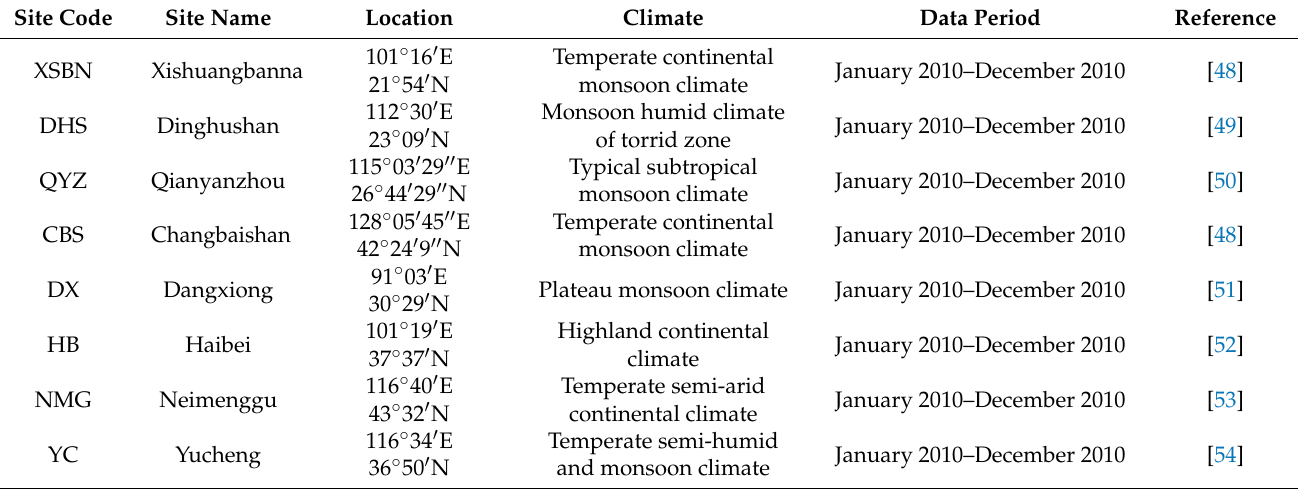
Table 1. Detailed description of sites